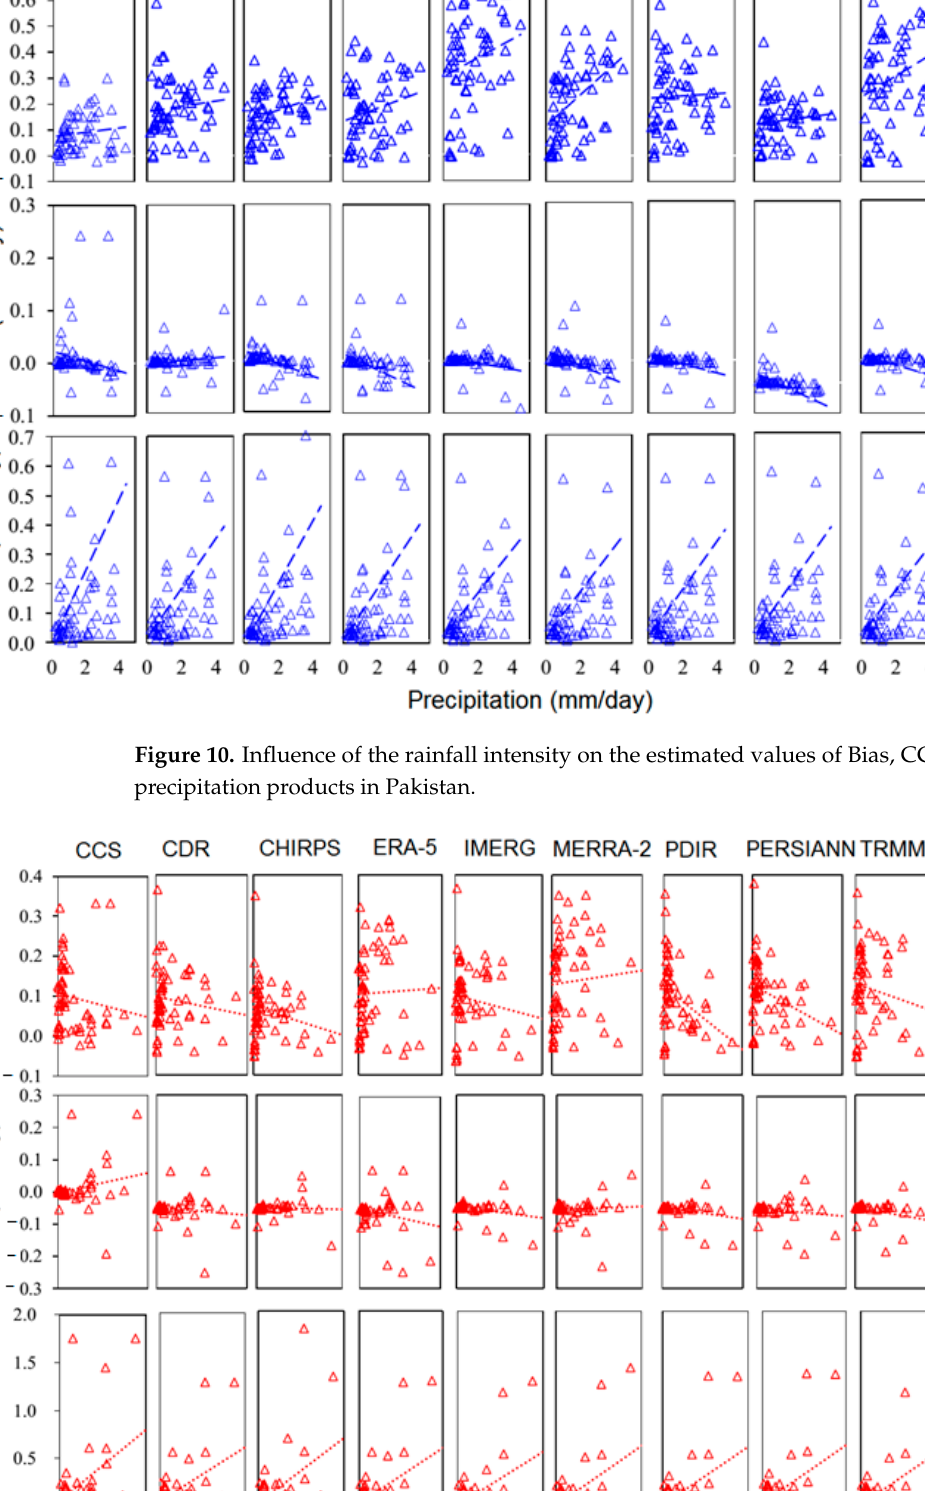
Figure 12. Spatial distribution of CC values estimated for nine precipitation products.